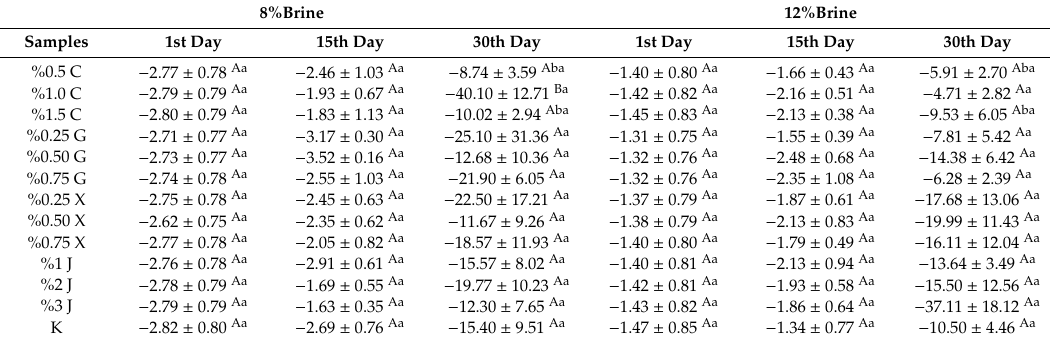
Table 9. Adhesiveness (g.sn) cheese of samples during